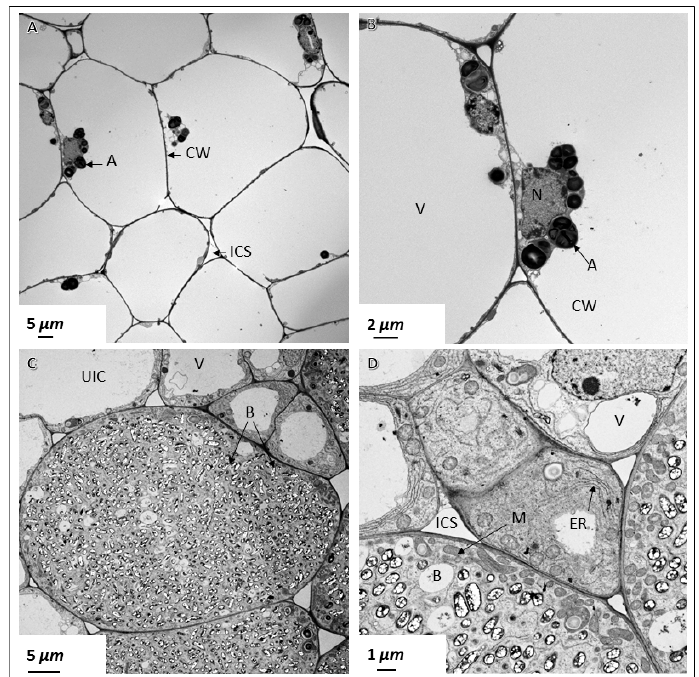
Figure 5. Transmission electron micrographs of pigeon pea nodules. Thin sections of 30 DAI pigeon